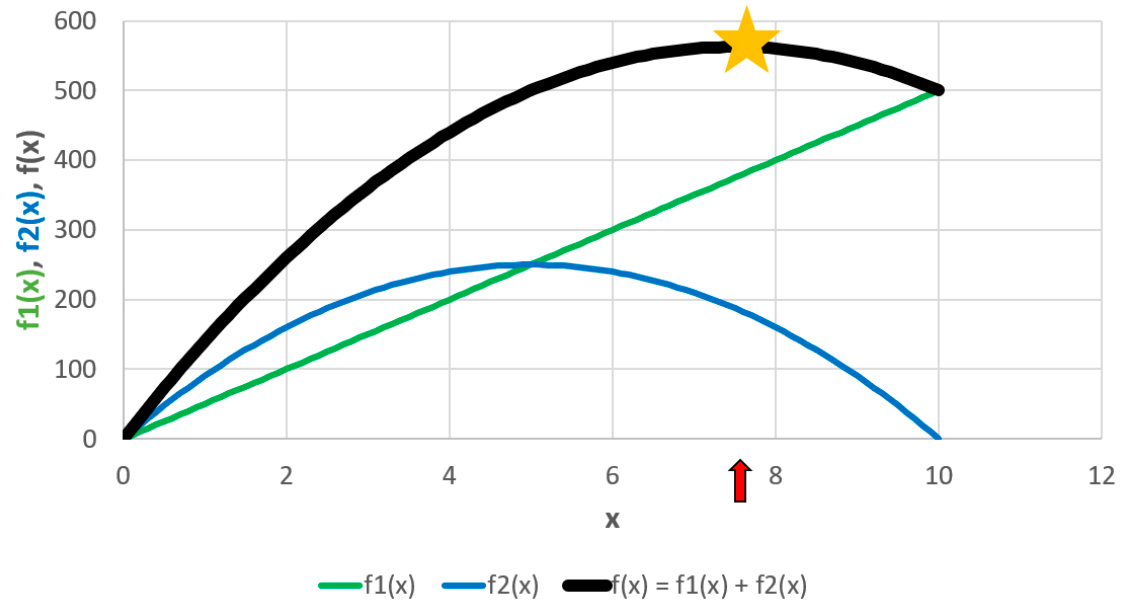
Figure 5. The optimized location of the war front based on the total objective function. The optimal war front is now located between the different solutions that were optimal with consideration of the objective functions f 1 (x) and f 2 (x).